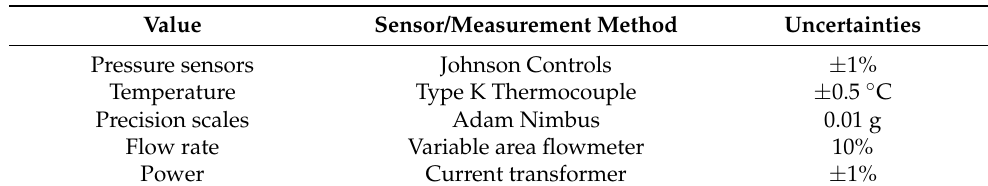
Figure 4. Test bench for the preliminary test.